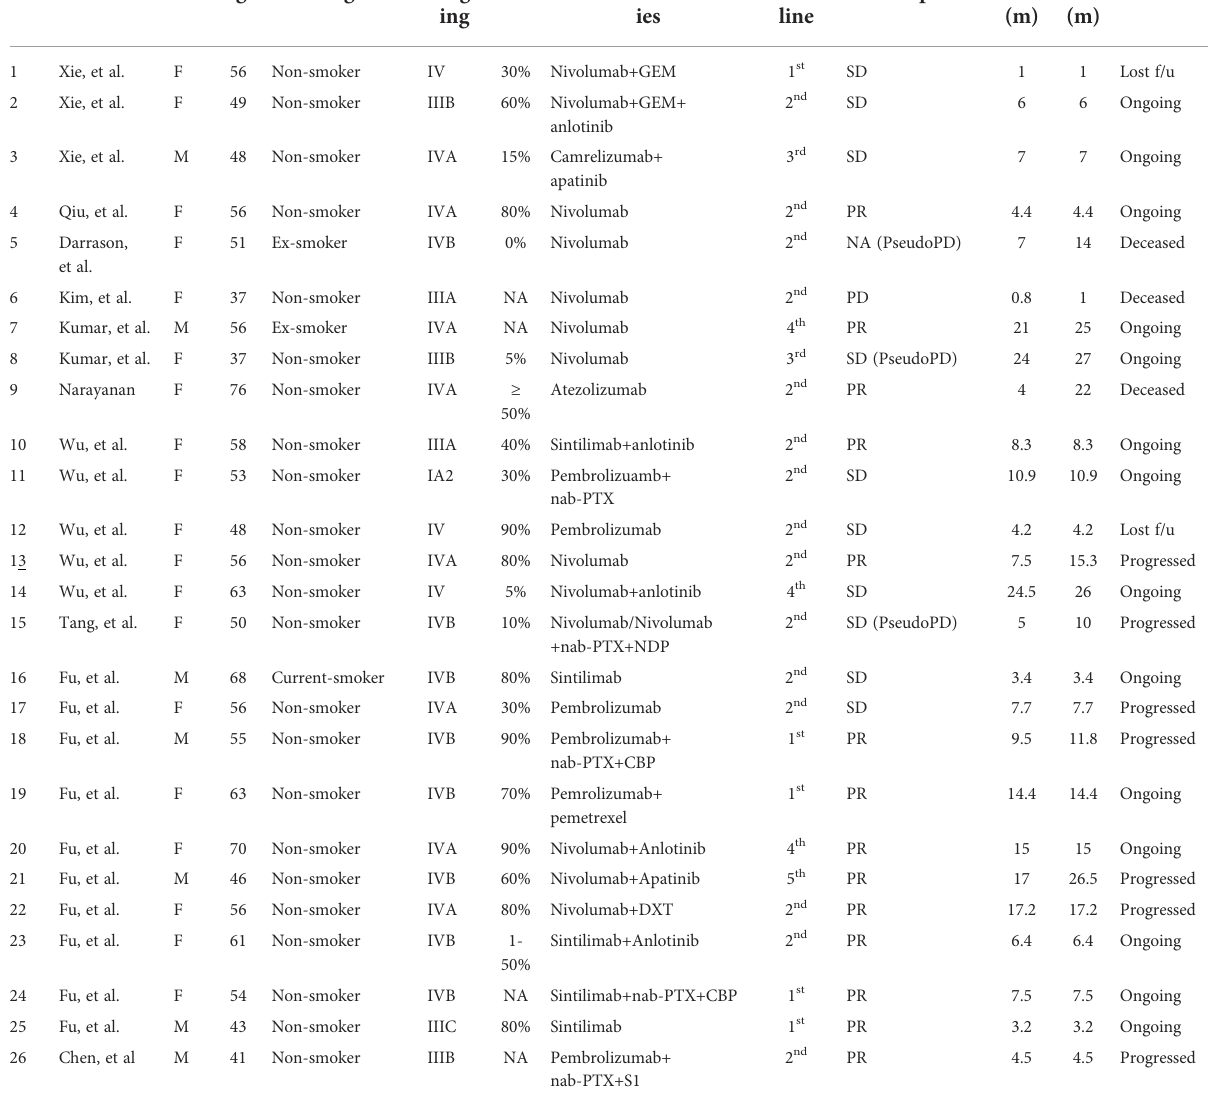
TABLE 2 Summaries of the literature review. No. References Sex Age SmokingStatus Stag-